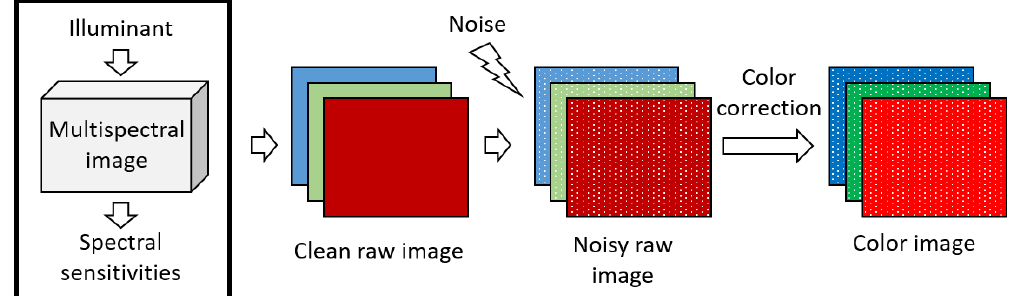
Figure 2. Simulation framework to display raw noisy and corrected